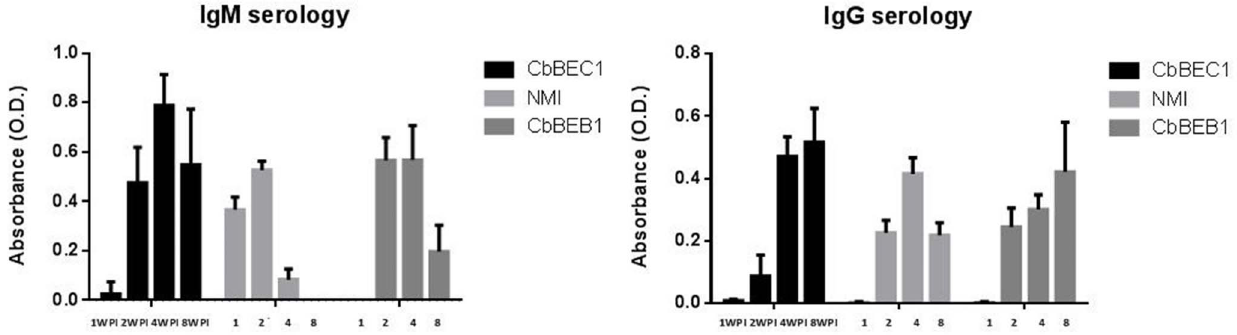
Figure 5. Mice anti- C.burnetii IgM and IgG assayed by ELISA at various time-points. IgM (left panel) and IgG (right panel) average levels of anti- C. burnetii antibodies as measured by ELISA in NMI, CbBEB1 and CbBEC1 infected mice at 1, 2, 4 and 8 weeks post-infection. Optical density values (O.D.) were normalized with values from uninfected control mice. Each value shown is the mean value determined on 5 mice + / 2 SE.